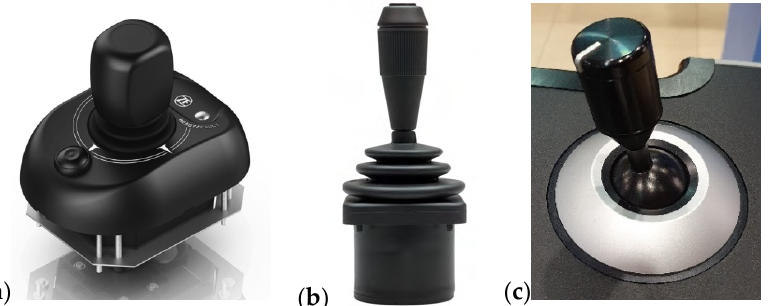
Figure 5. ( a ) CAN 3DOF joystick station by ZF, ( b ) USB 3DOF joystick by Apem used in the research, and ( c ) their counterpart by Kongsberg used in K-Pos DP systems.